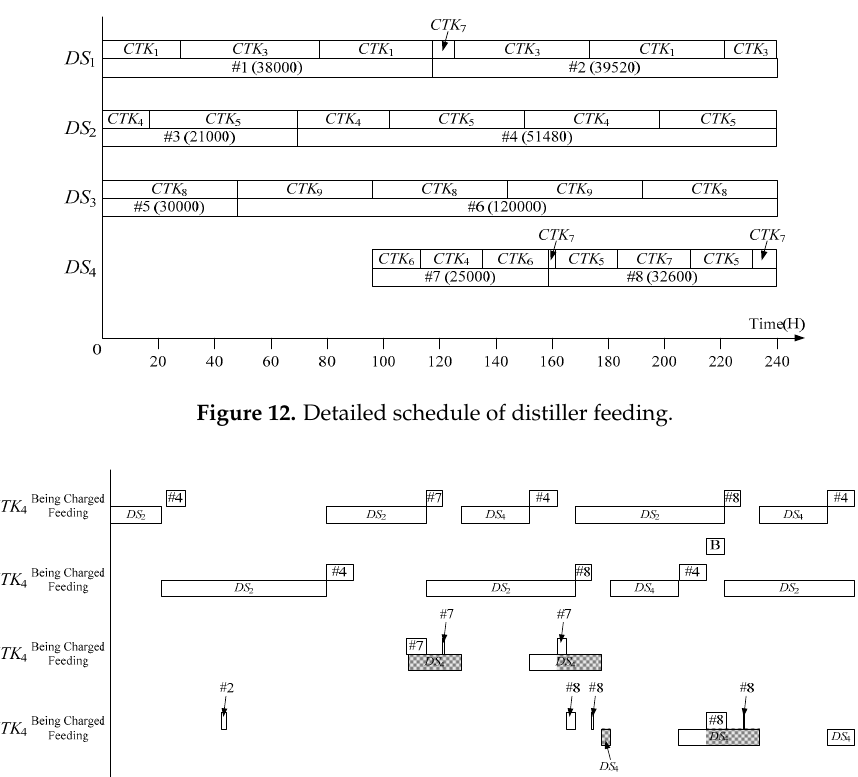
Figure 13. The schedule of charging tanks for being charged and feeding distillers.